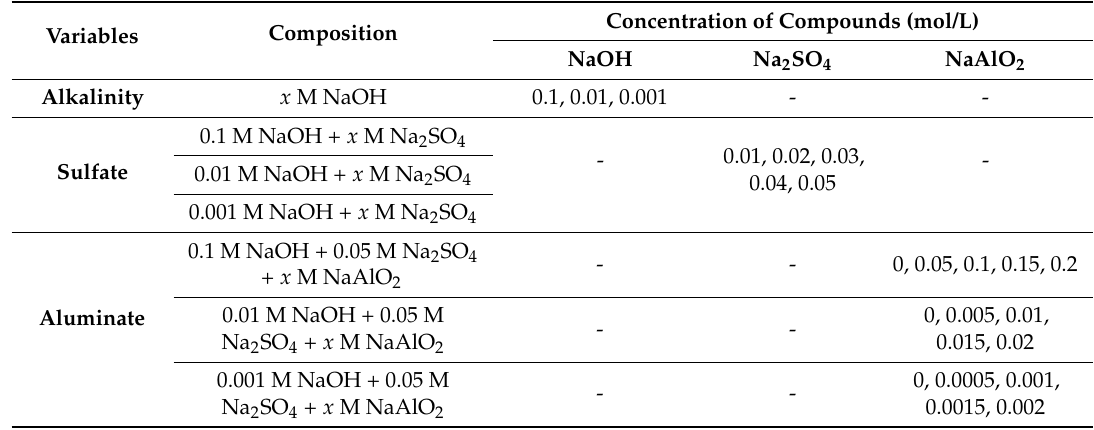
Table 2. Constitutions of simulated pore solutions.